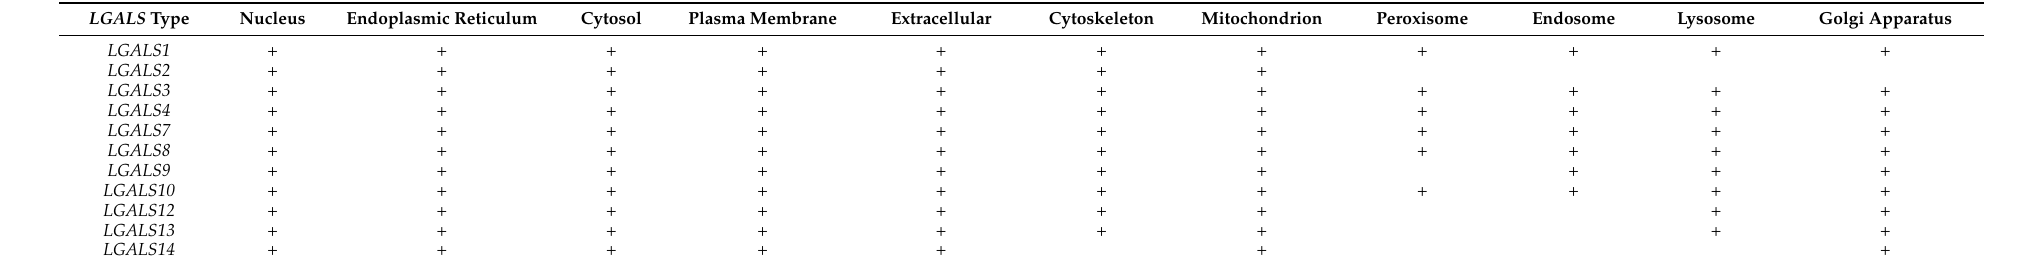
Table 5. Subcellular distribution of